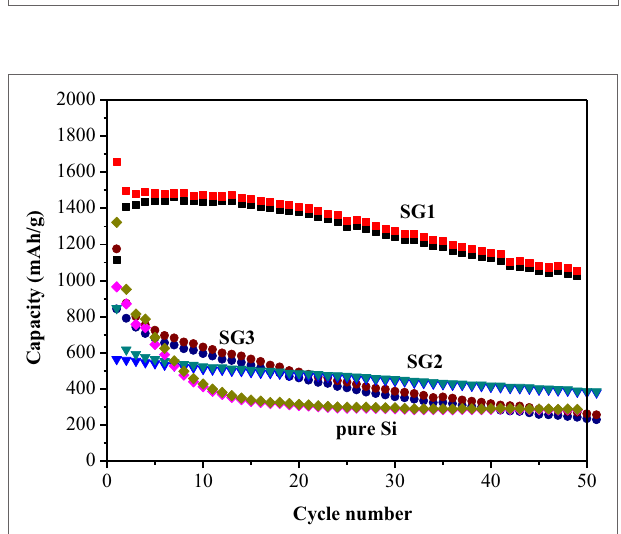
FigUre 5 | (a) Cycling performance of pure Si, SG1, and SEG, (B) rate performance of SG1 at current densities from 0.2 to 2.0 A g − 1 between 0.01 and 3.0 V.